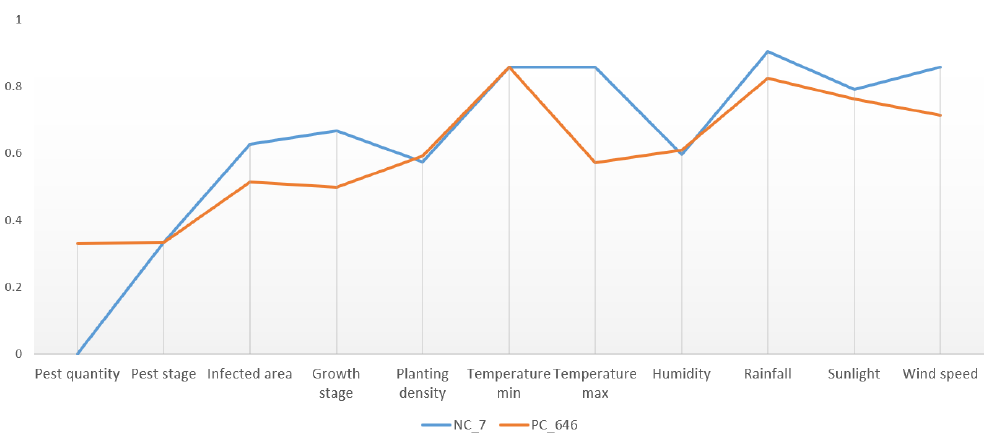
Figure 11. Data visualization of the new case 7 and the retrieved most similar case (past case 646) after normalization. Table 8. Statistical analysis of the new case 7 and retrieved top three similar past cases.